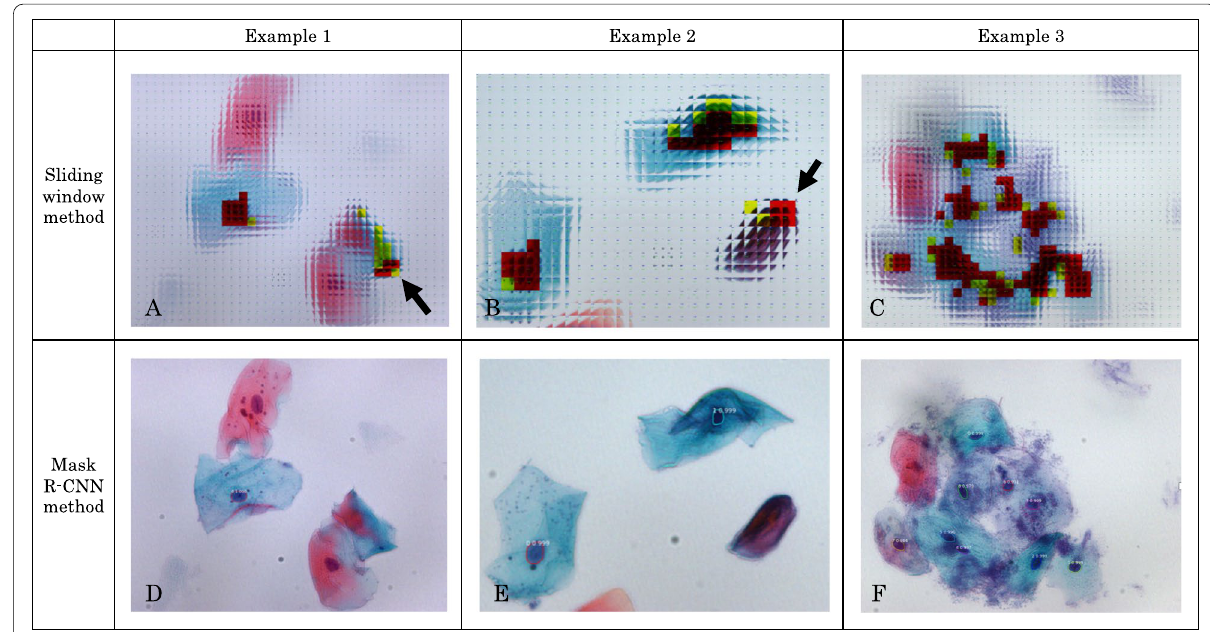
Fig. 5 Comparison of the detection accuracy between the sliding window method (SWM) and mask region-based convolutional neural network (Mask-RCNN) method using the same image. A , B , and C show the SWM, while D , E , and F show the Mask-RCNN (at the end of epoch 40). A , B The non-nuclear regions (arrows) are indicated in red, while C discriminates the nucleus regions in red but in a wider range. By contrast, D , E , and F are only identified as cell nuclei in